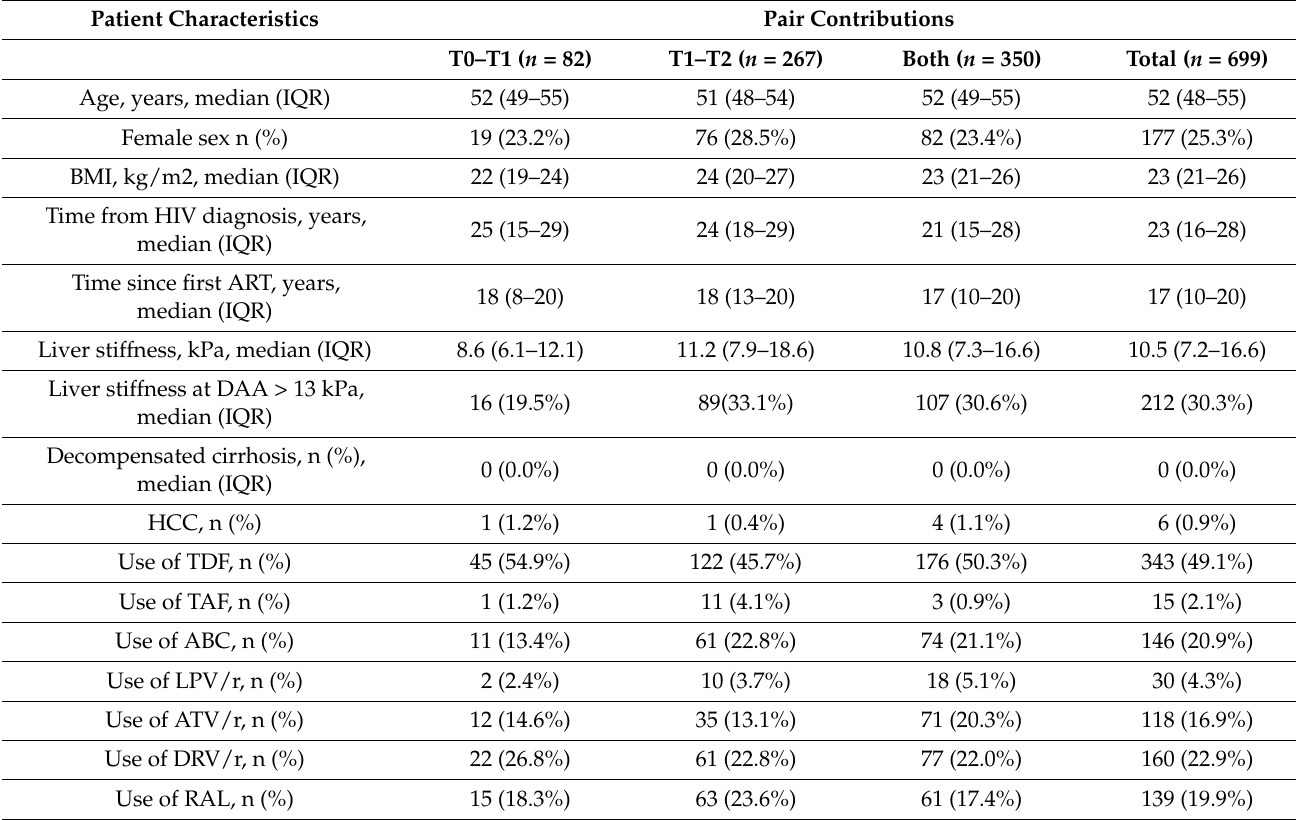
Table 1. Participants’ characteristics according to pair contributions. BMI: body mass index; ART: antiretroviral therapy; HCC: hepatocellular carcinoma; TDF: tenofovir disoproxil-fumarate; TAF: tenofovir alafenamide; ABC: abacavir; LPV/r: ritonavir boosted lopinavir; DRV/r: ritonavir-boosted darunavir; ATV/r: ritonavir-boosted atazanavir; and RAL: raltegravir.